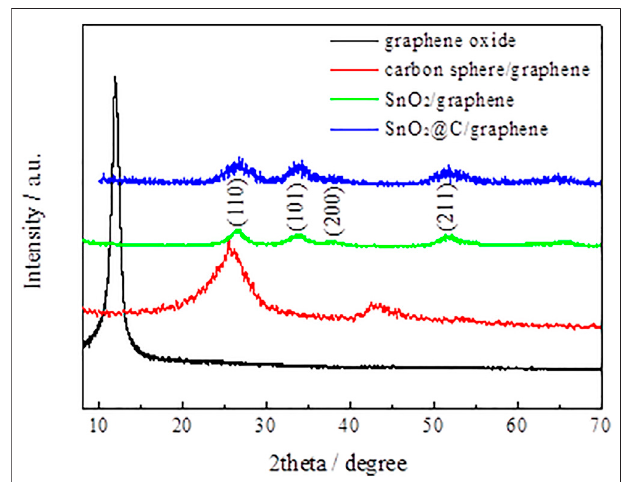
FIGURE1| XRDpatternsofgrapheneoxide,carbonspheres/graphene, SnO 2 /graphene, and SnO 2